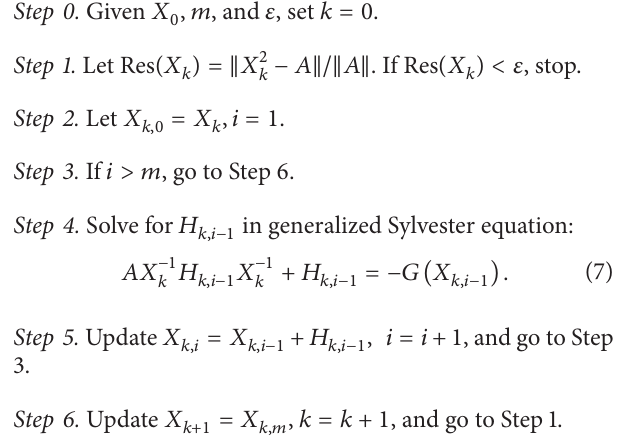
Algorithm 3 (Newton’s method for (3) with Samanskii tech- nique). We consider the